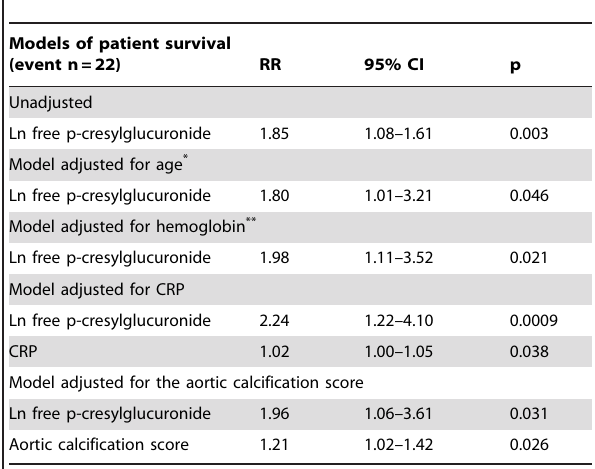
Table 4. Univariate and multivariate Cox regression analysis of risk factors at baseline for all-cause mortality, with free p- cresylglucuronide entered as a continuous variable in all patients (n =139).